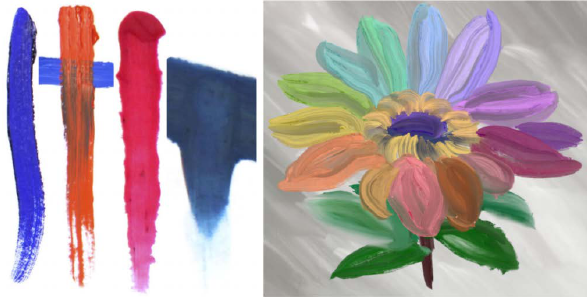
Fig. 13 Results from RealBrush [75]. Left: physically painted strokes are captured with a camera to create a digital library of natural media. Right: an artist has created a digital painting. RealBrush synthesizes realistic brush texture in the digital painting by sampling the oil paint and plasticine exemplars in the library. Reproduced with permission from Ref. [75], c (cid:13) Association for Computing Machinery, Inc. 2013.